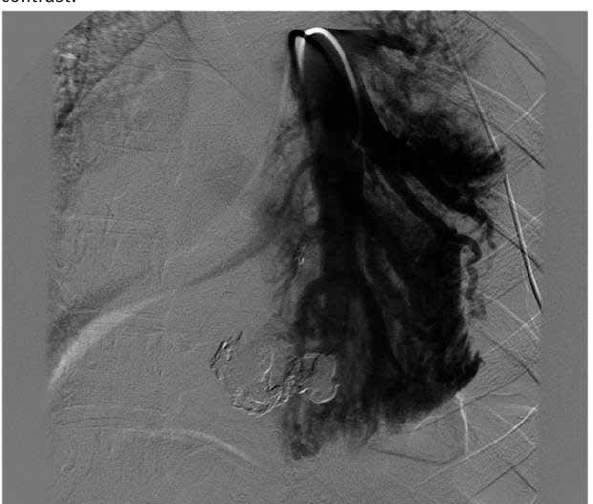
Figure 3: Interventional radiologist-guided embolisation of the left pulmonary artery which was the culprit vessel.